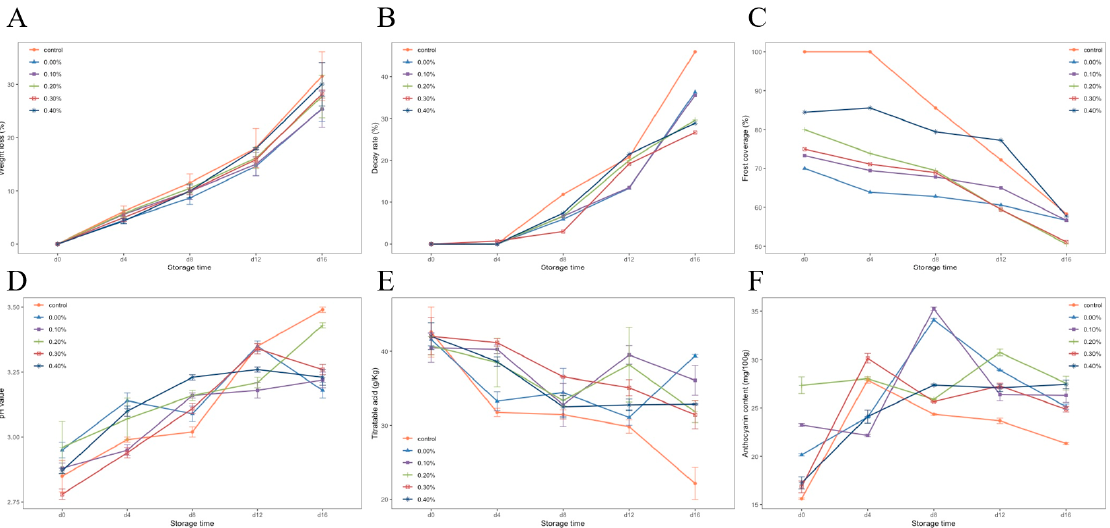
Figure 5. Weight loss rate ( A ), decay rate ( B ), frost cover index ( C ), pH ( D ), titratable acidity ( E ), and anthocyanin content ( F ) of blueberries during storage.